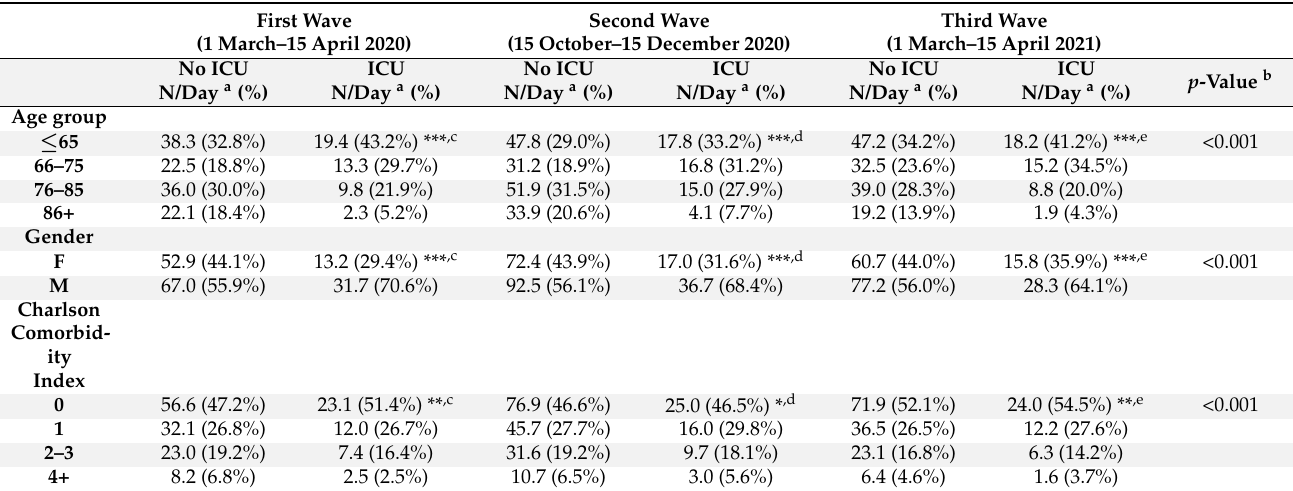
Table 3. Demographic characteristics, comorbid conditions, and death from COVID-19 of patients hospitalized for SARS-CoV-2, stratifying by admission to intensive care unit (ICU) and